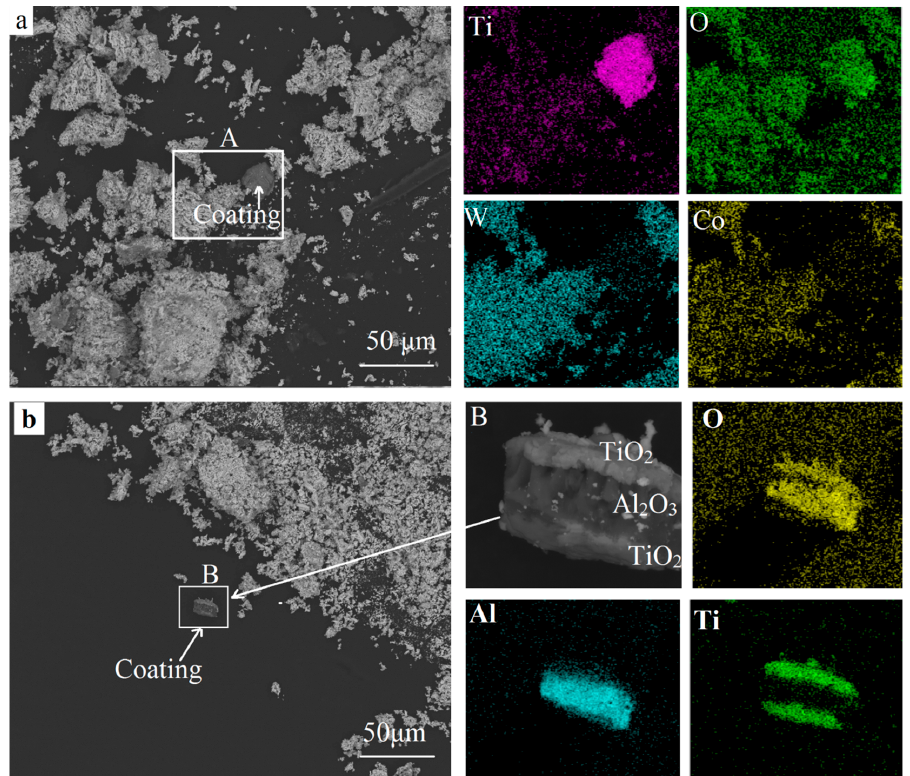
Figure 7. SEM images and the EDS results of the recycled oxides. ( a ) gray coating in final oxides; ( b ) multlayer coatings in final oxides.